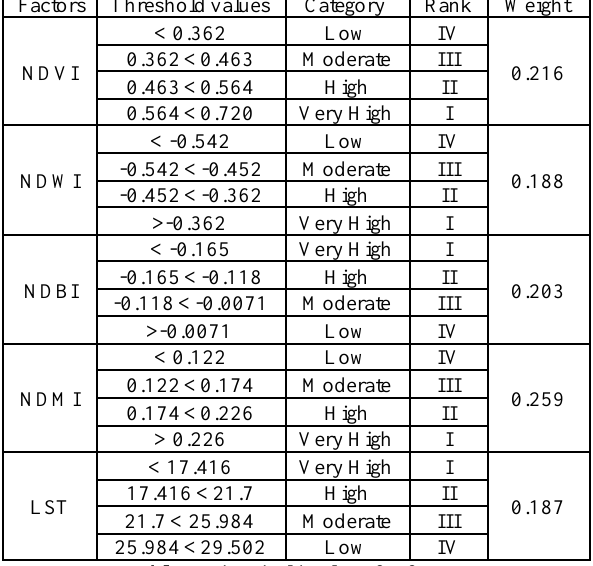
Table 2. Threshold values for factors